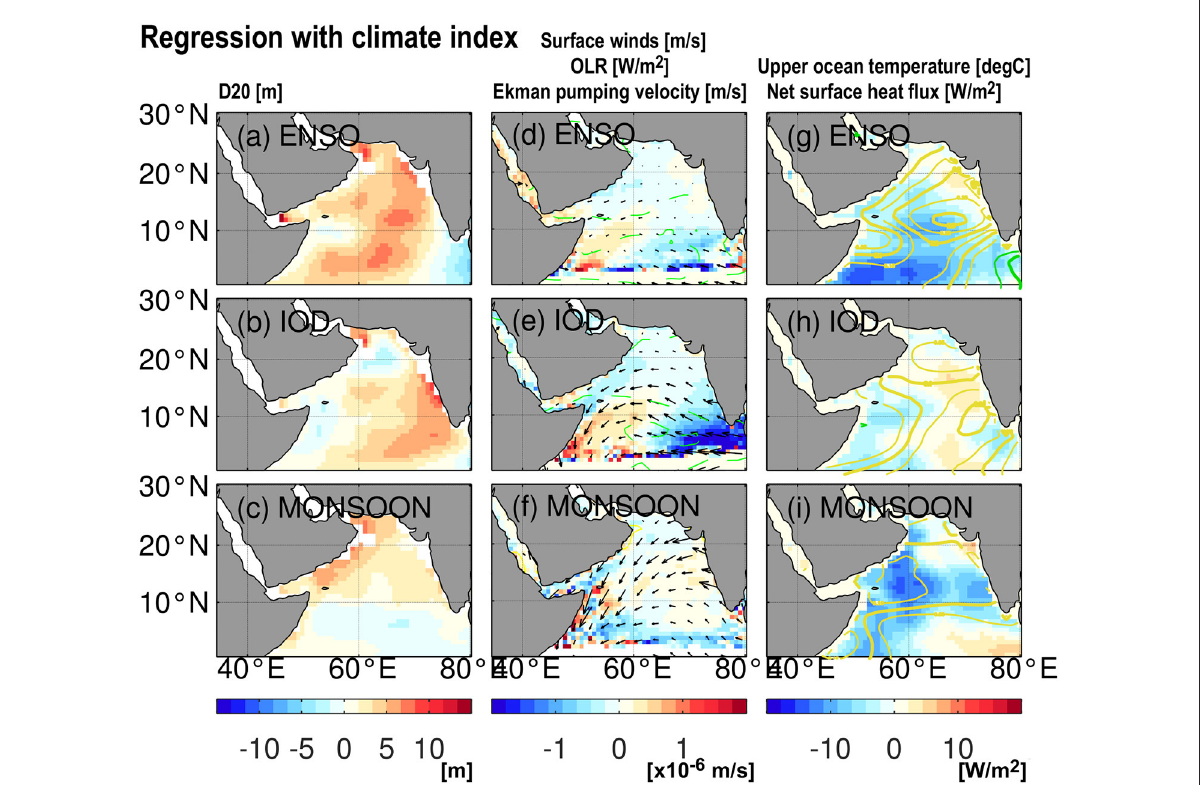
FIGURE6 Regression maps of D20 anomalies with (a) ENSO, (b) IOD, and (c) monsoon indices in the peak seasons during the period 1993–2016. Central panels (d–f) are as in the left panels, but show the regression maps of surface winds (vectors), outgoing longwave radiation (OLR) (contours), and Ekman pumping velocity (shades). Yellow and green contours represent positive and negative values, respectively. The contour interval is 2.5 Wm − 2 . Right panels (g–i) are as in the left panels, but show the regression maps of net heat flux at the sea surface (shades) during the period 1993–2009 and the vertically averaged ocean temperature upper 300m depth (contours). Positive and negative heat flux values represent the heat input and output of the ocean, respectively. Yellow and green contours represent positive and negative values, respectively. The contour interval is 0.05 ◦